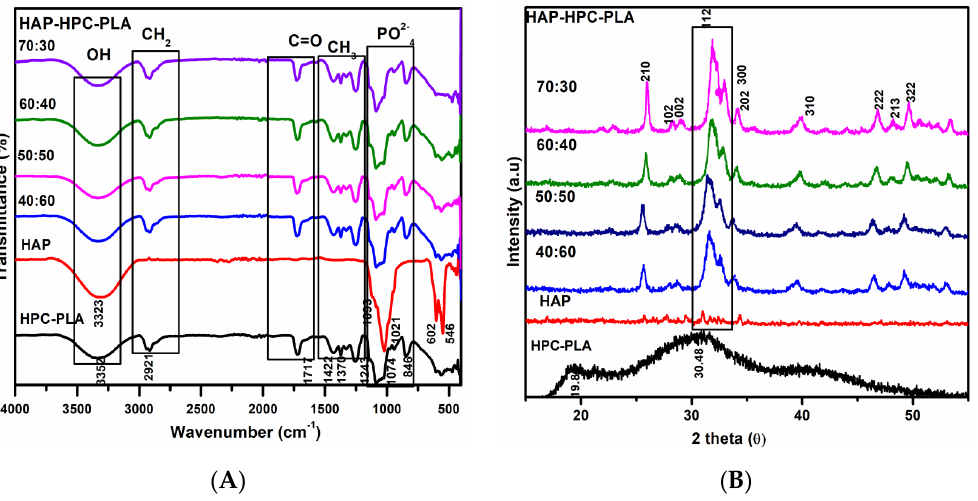
Figure 2. ( A ) FTIR and 2 ( B ) XRD (X-ray diffraction) analysis of HAP-HPC/PLA nanofibers of dif- ferent